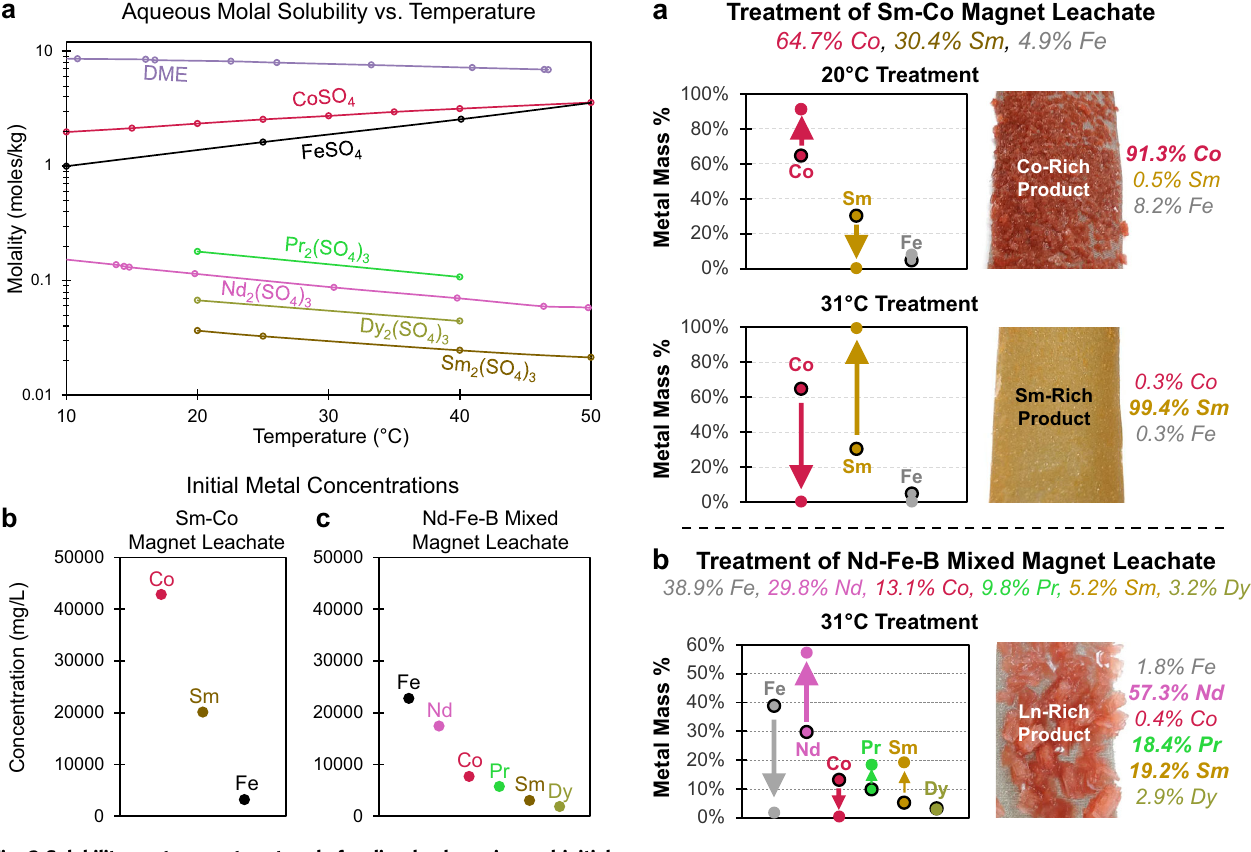
Fig. 2 Solubility vs. temperature trends for dissolved species and initial Fig. 3 Compositional data for solid products of DME-FC. a Solid products leachate metal concentrations. a Molal solubility limits vs. temperature for obtained from DME-FC of the Sm-Co magnet leachate at 20 and 31 °C. DME 81 (at suf fi cient pressure to condense a liquid DME phase) and metal b Solid product obtained from DME-FC of the Nd-Fe-B mixed magnet sulfates contained in the two studied permanent magnet leachates in the leachate at 31 °C. ICP-OES acquired mass percent compositions are plotted temperature range from 10 – 50 °C 73 – 75 . ICP-OES measurement of metal at left (arrows indicate the shift from the original leachate composition to concentrations in the b Sm-Co magnet leachate and c Nd-Fe-B mixed solid product composition). Associated separation factors are listed in magnet leachate. Source data are provided as a Source Data fi Table 1. Photographs of the solid products as precipitated on nucleation scaffolds are shown at right. Source data are provided as a Source Data fi le. ; coef fi cients, K , as determined in this work by the ratio of metal d in the solid product relative to that in the original aqueous phase,